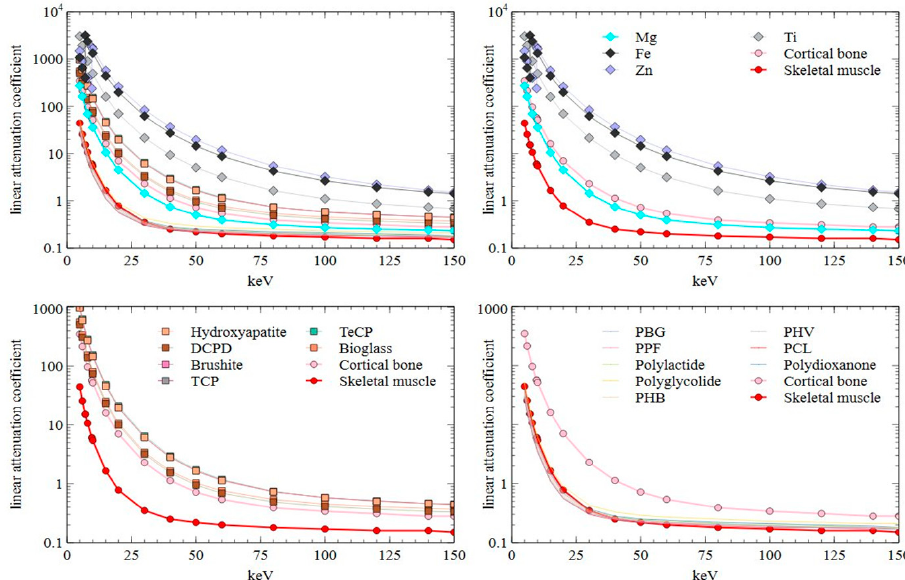
Figure 5. Plotted linear attenuation coefficient data of biodegradable implant materials and cortical bone and skeletal muscle. PBG = poly( γ -benzyl-L-glutamate); PPF = polypropylene fumarate; PHB = polyhydroxybutyrate; PHV = polyhydroxyvalerate; PCL = polycaprolactone.